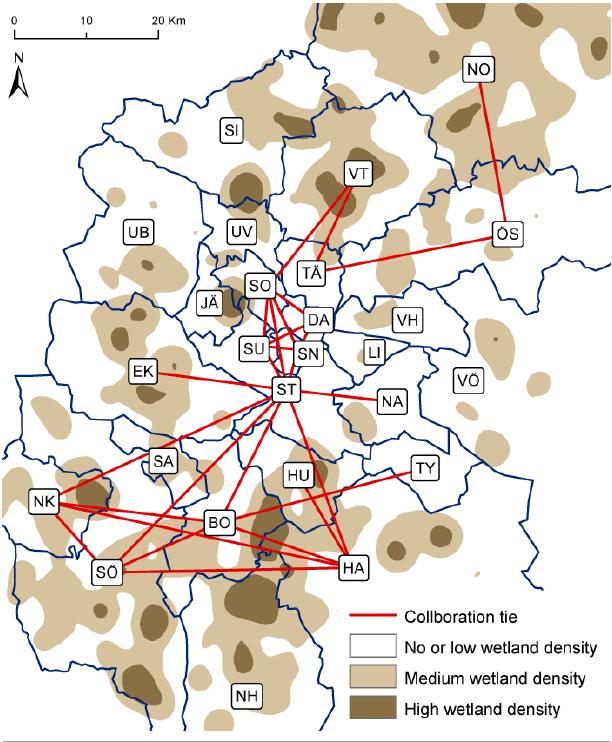
Fig. 3 . Collaboration network and density-based wetlands aggregation. The names of the municipalities are abbreviated as follows: BO = Botkyrka, DA = Danderyd, EK = Ekerö, HA = Haninge, HU = Huddinge, JÄ = Järfälla, LI = Lidingö, NA = Nacka, NO = Norrtälje, NK = Nykvarn, NH = Nynäshamn, SA = Salem, SI = Sigtuna, SO = Sollentuna, SN = Solna, ST = Stockholm, SU = Sundbyberg, SÖ = Södertälje, TY = Tyresö, TÄ = Täby, UV = Upplands Väsby, UB = Upplands-Bro, VT = Vallentuna, VH = Vaxholm, VÖ = Värmdö, ÖS =